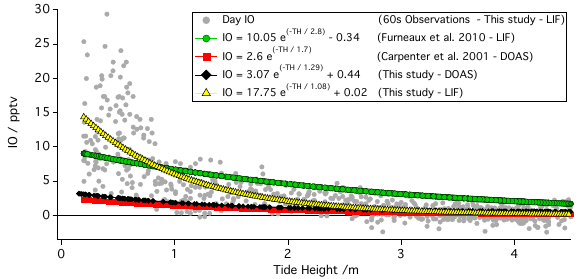
Fig. 9. IO as a function of tide compared to other studies. Point ob- servations of IO by LIF presented in this study (one minute data: grey points, tidal dependance: yellow triangles), Furneaux etal. (2010) point observations by LIF at Roscoff, France (green points), Carpenter etal. (2001) LP-DOAS observations at Mace Head (red squares), LP-DOAS observations from this study (black diamonds). Point observations of IO (by LIF) show the strongest dependance on tide height.